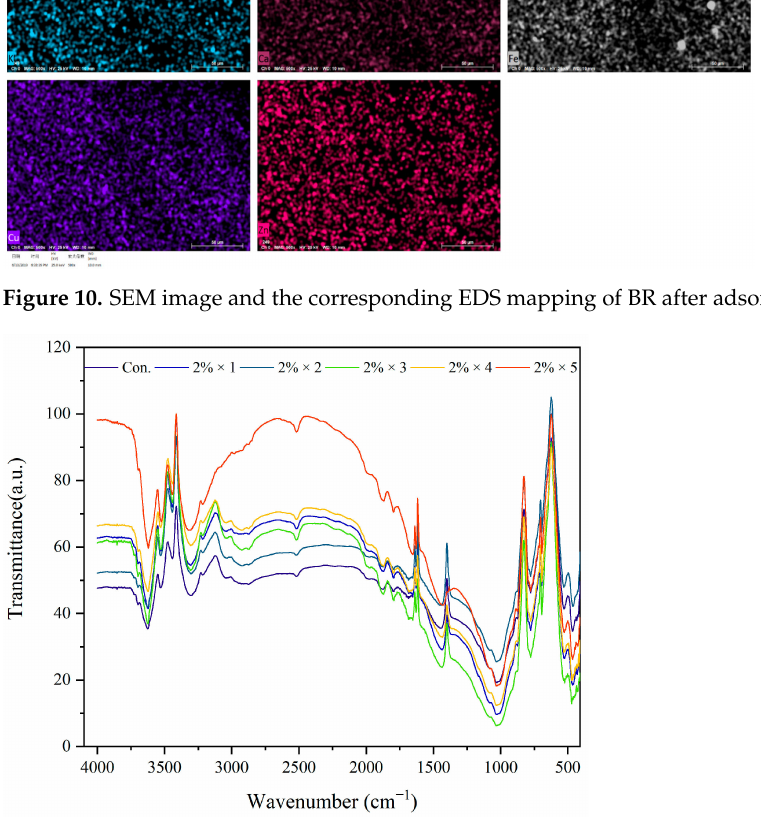
Figure 11. The FTIR spectrums of SASs (Con.) and application of 2% BR for one season (2% × 1), two seasons (2% × 2), three seasons (2% × 3), four seasons (2% × 4), five seasons (2% ×